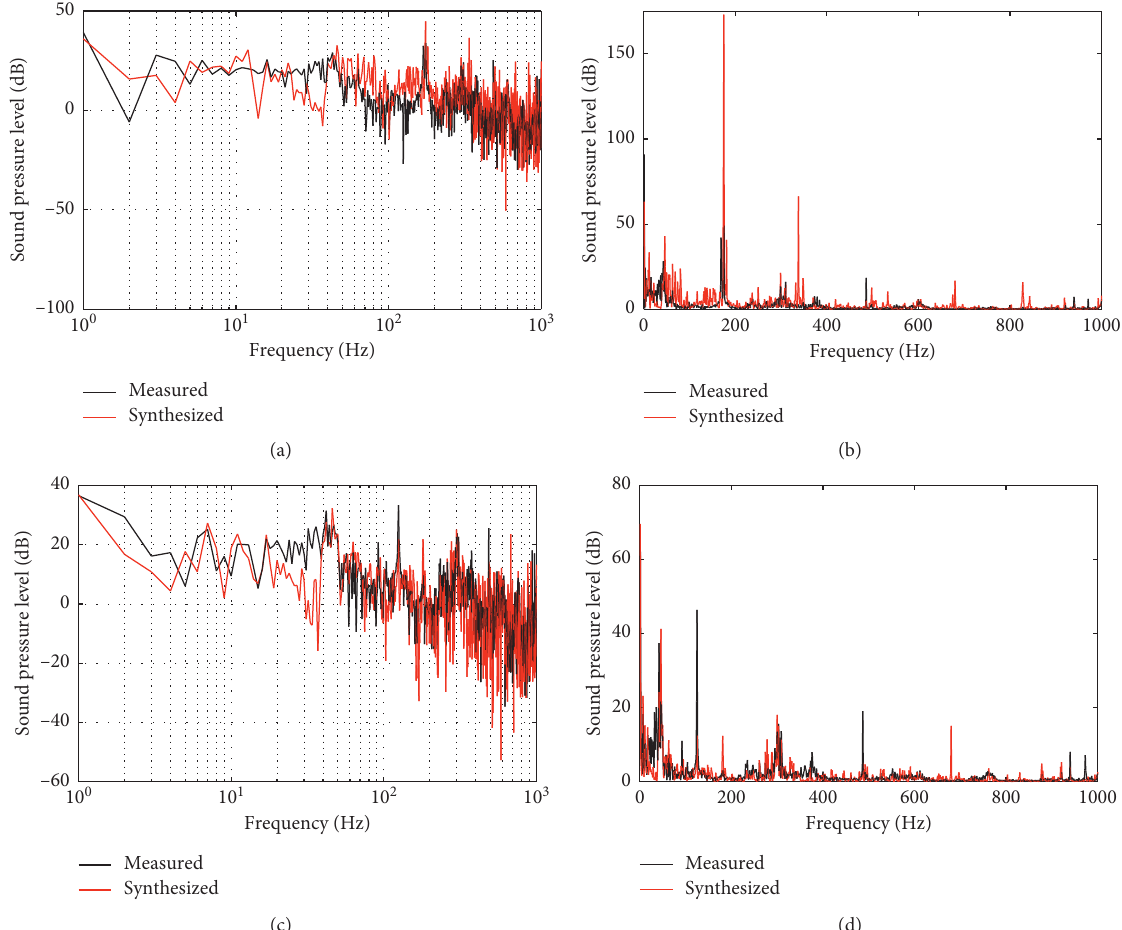
Figure 13: Response synthesis. Sound pressure level (left) and spectrums (right): (a) test measurement 1; (b) test measurement 1; (c) test measurement 2; (d) test measurement